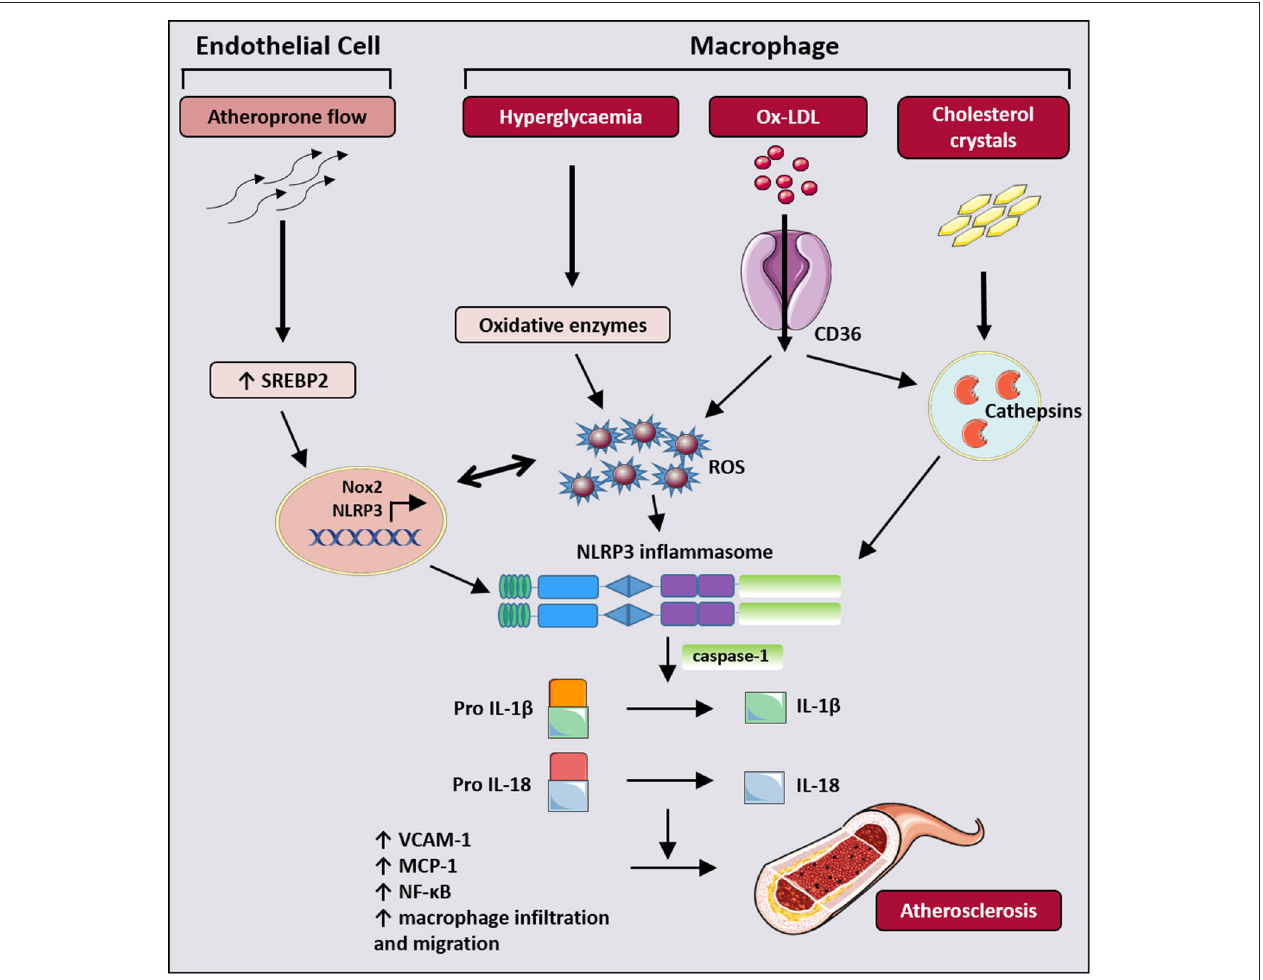
FIGURE 3 | Graphic summary of NLRP3 activation to promote atherogenesis. In endothelial cells, atheroprone or disturbed flow activates sterol regulatory element binding protein 2 (SREBP2) which induces expression of the ROS producing enzyme Nox2 and NLRP3. In macrophages, NLRP3 activation is mediated by the increased presence of glucose-mediated ROS, ox-LDL and cholesterol crystals in diabetic and atherogenic settings. The resultant secretion of IL-1 β and IL-18 by both cell types in turn contribute to endothelial dysfunction, macrophage recruitment, migration and activation, and the upregulation of inflammatory mediators including VCAM-1, MCP-1, and NF- κ B, leading to progression of atherosclerosis.